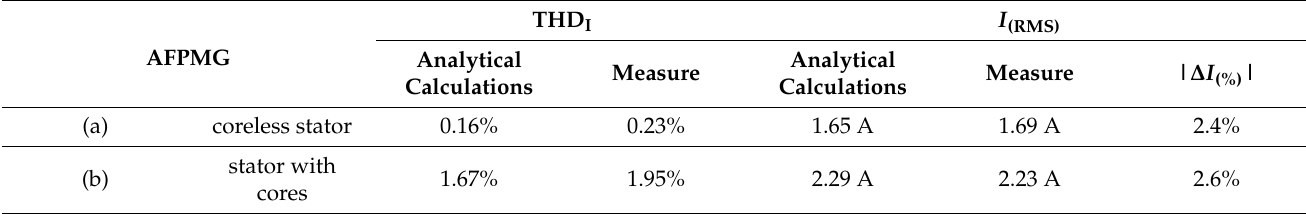
Table 4. Comparison of the results obtained from analytical models and laboratory tests for current i 1 .